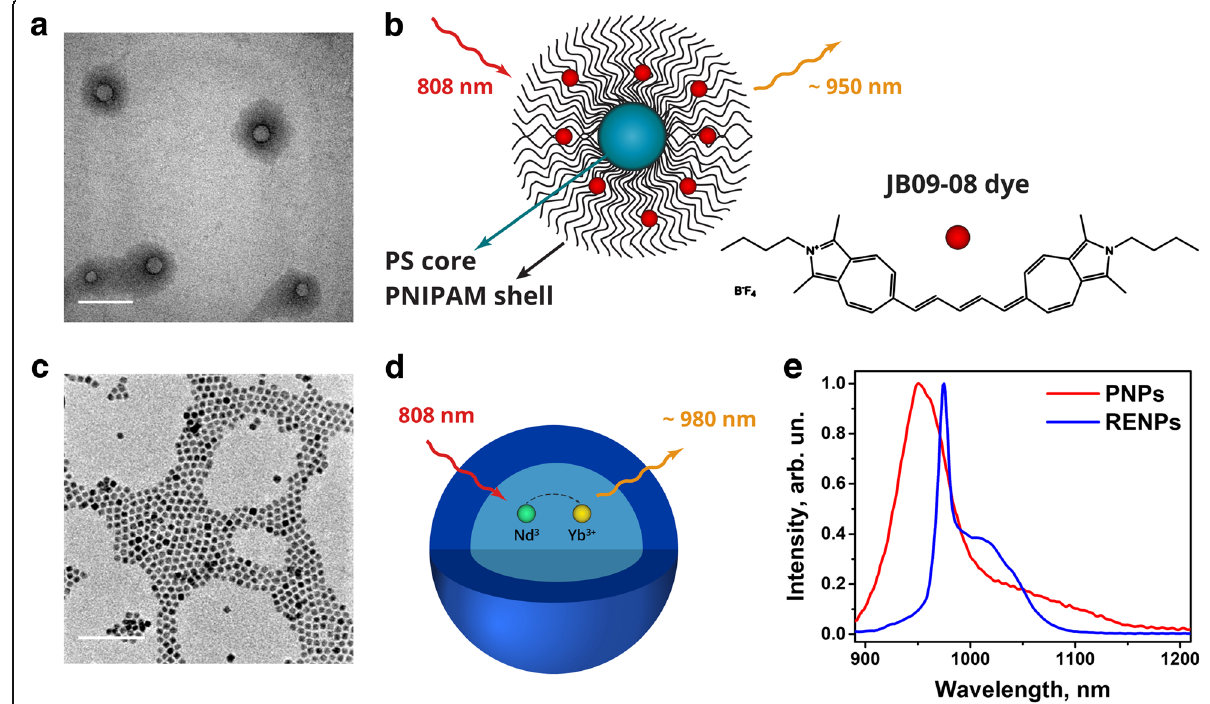
Fig. 3 Characterization of PNPs and RENPs. TEM image ( a ) and schematic structure ( b ) of PNPs loaded with JB9-08 dye. TEM image ( c ) and schematic structure ( d ) of RENPs. e Normalized PL emission spectra of PNPs-JB9-08 and RENPs suspensions under 808 nm excitation. Scale bars, 100